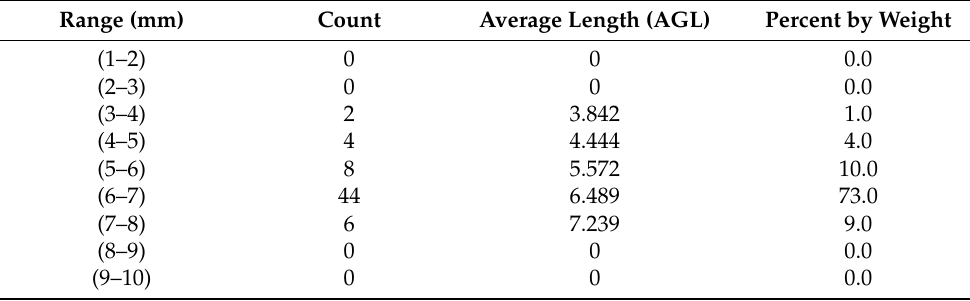
Table 1. Average length of the rice kernels from the sample and its weighted